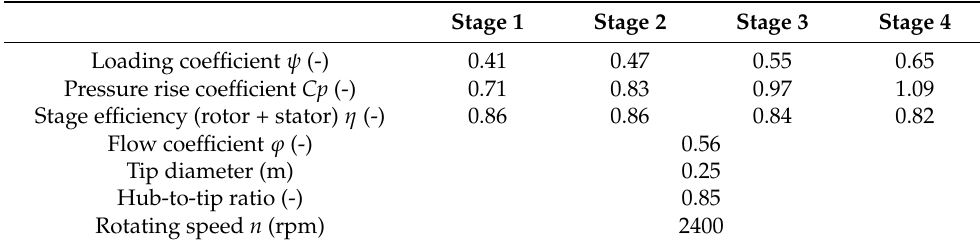
Table 1. Design parameters for different compressor